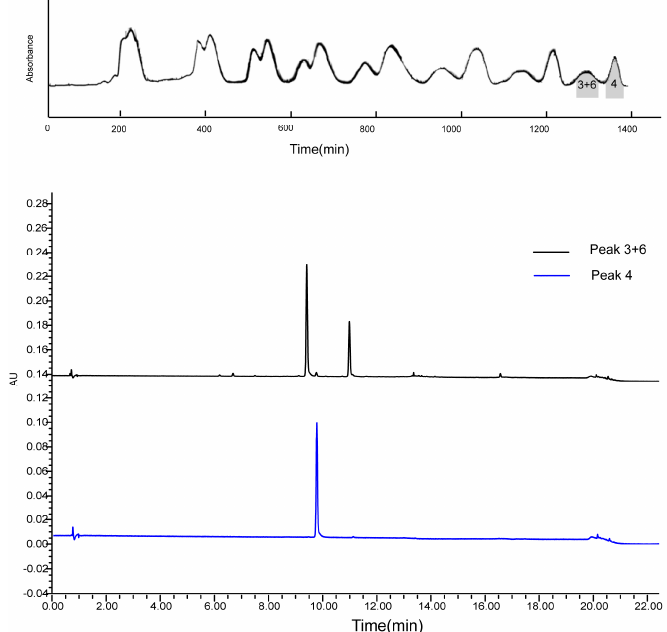
Figure 6. 2D R-HSCCC chromatogram of Fr.2 and HPLC chromatogram of the two HSCCC fractions (Peak 3 + 6: the mixture of neoastilbin and isoastilbin; Peak 4: astilbin). HSCCC conditions were the same as it in Figure 4.